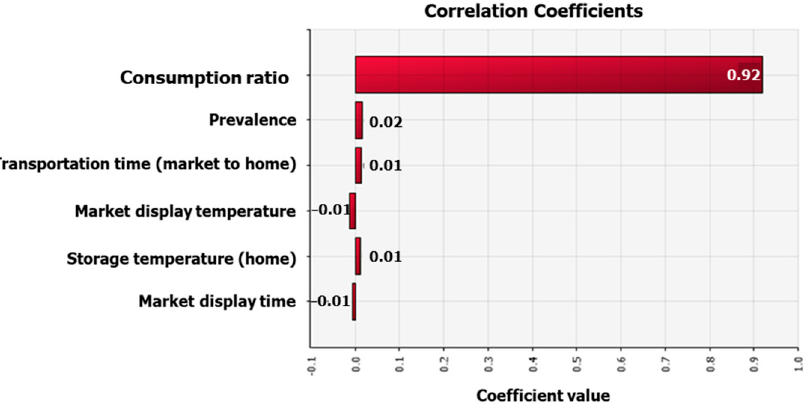
Figure 5. Correlation coefficient values for risk factors influencing the probability of hepatitis A virus-related foodborne illness caused by fermented clam